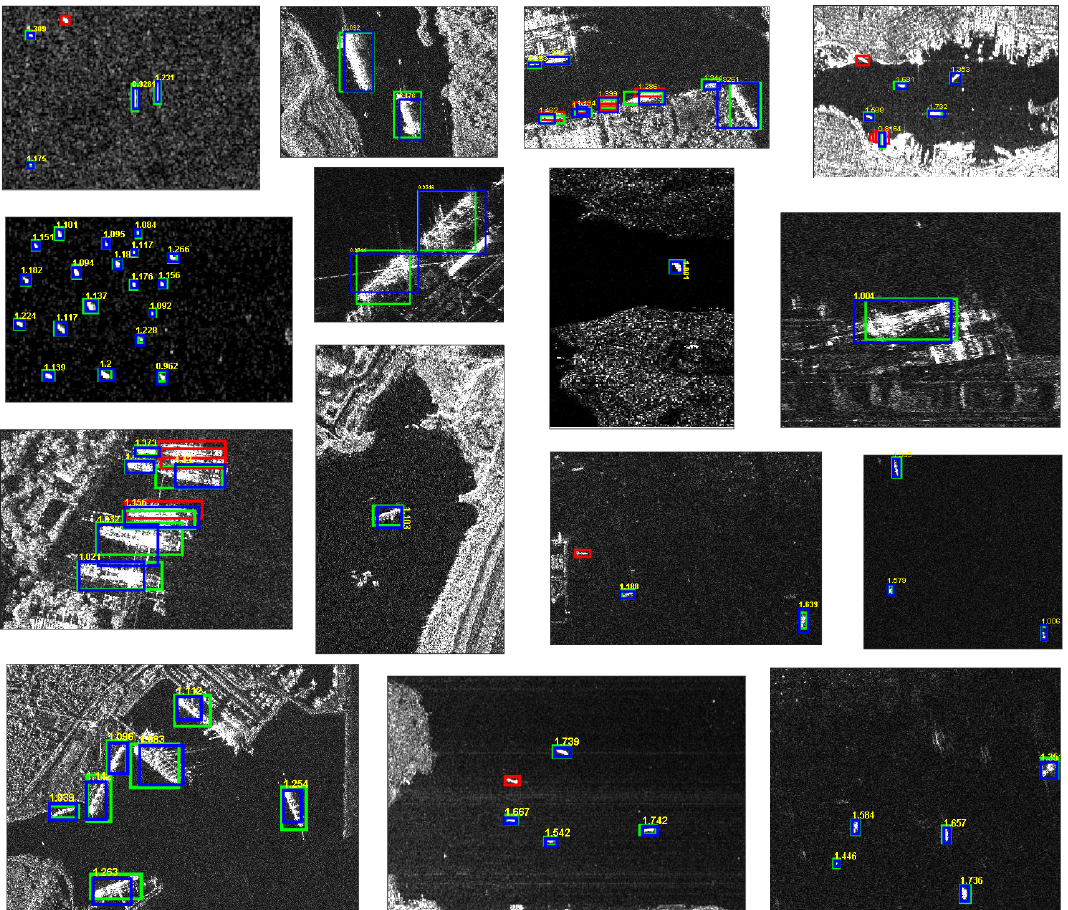
Figure 13. Some results of the proposed method. Blue bounding boxes are the closest produced object proposals to each ground truth. Green and red bounding boxes are ground truth bounding boxes. Green represents a ship was found and red indicates that the ship was not found. The yellow numbers are the scores of bounding